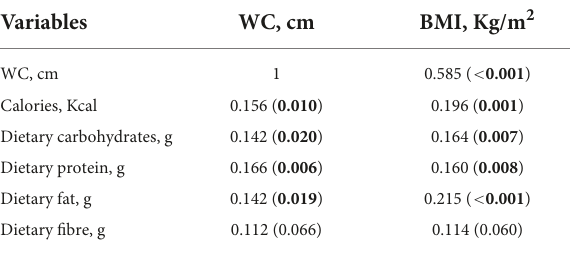
TABLE 5 Pearson correlation between calories, macronutrient intakes, and anthropometric